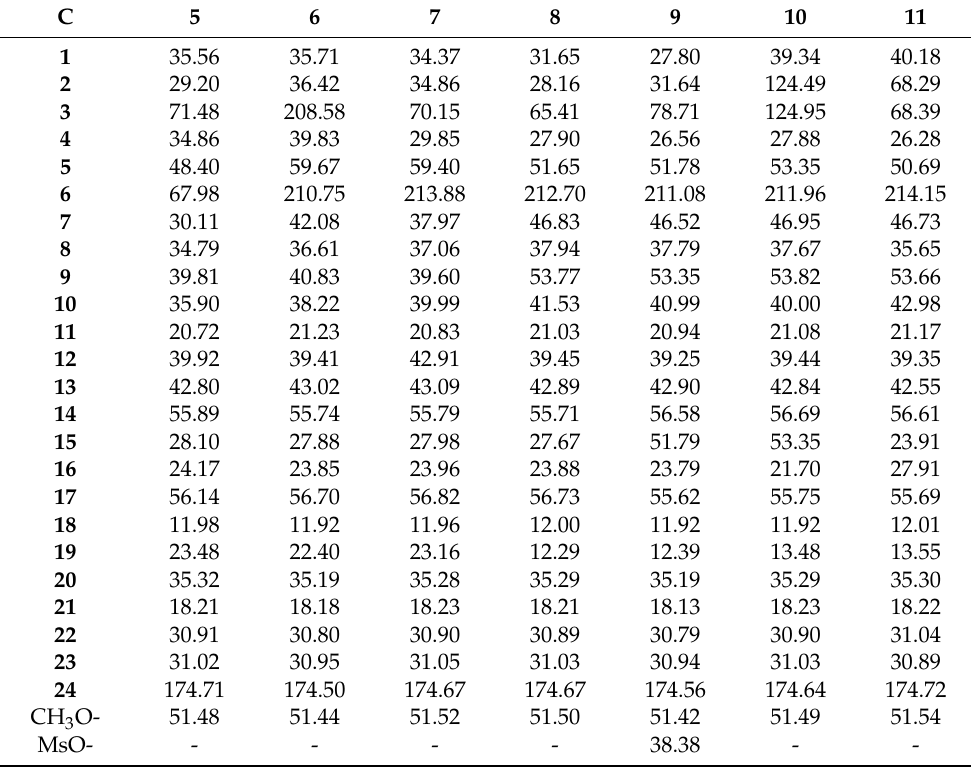
Table 2. Chemical shifts, δ , of 13 C-RMN (CDCl 3 , 100.6 MHz) for compounds 5 – 11